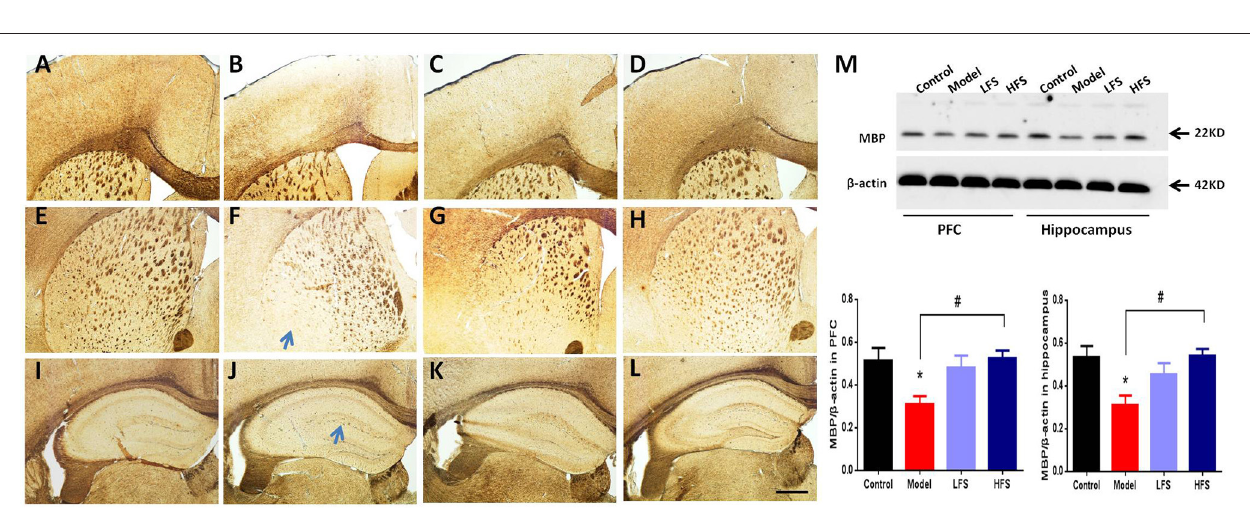
FIGURE 5 | DMS restores myelination defects due to cuprizone . Effects of 6 weeks of DMS treatment on MBP protein expression are shown. MBP staining in cortex is shown in (A–D) . (A) Control group. (B) model group. (C) LFS group. (D) HFS group. MBP staining in the striatum is shown in (E–H) . (E) Control group. (F) Model group. The blue arrow points to the lateral striatum. (G) LFS group. (H) HFS group. MBP staining in the hippocampus is shown in (I–L) . (I) Control group. (J) Model group. The blue arrow points to the dentate gyrus. (K) LFS group. (L) HFS group. Scale bar = 100 µ m. (M) Western blot and quantitative analysis of MBP expression in the prefrontal cortex and hippocampus. β -actin was used as an internal control. Values are expressed as mean ± SEM ( n = 4–5). * P < 0.05 vs. control group; # P < 0.05 vs. model